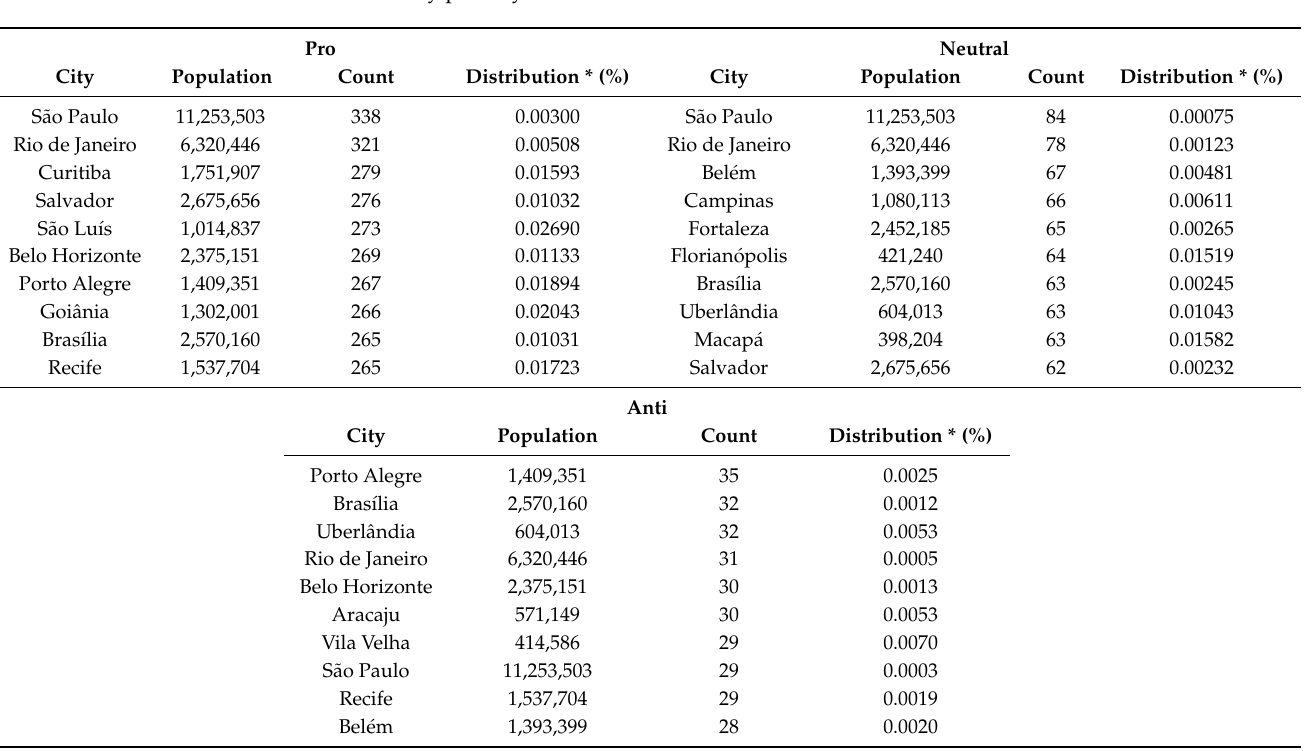
Table 2. Tweets’ counts and percentual distributions for each of the ten cities with the highest number of tweets by